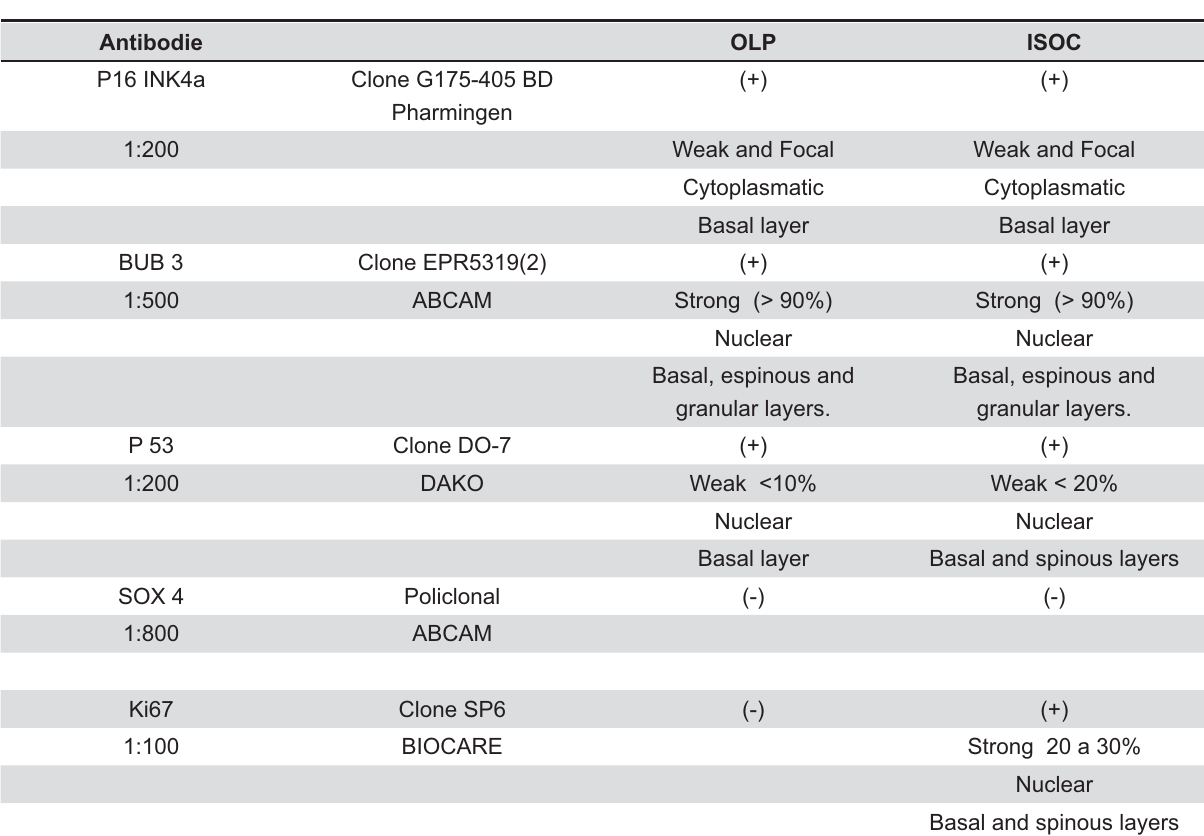
Table 1- Immunohistochemical